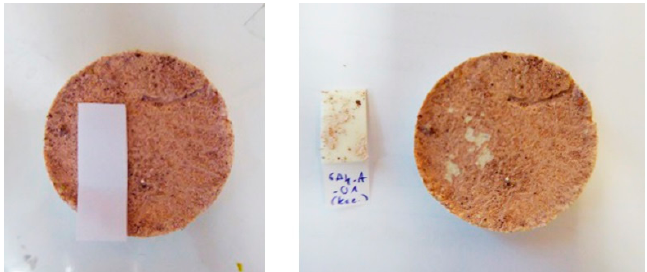
Figure 5. Adhesion test (scotch tape).